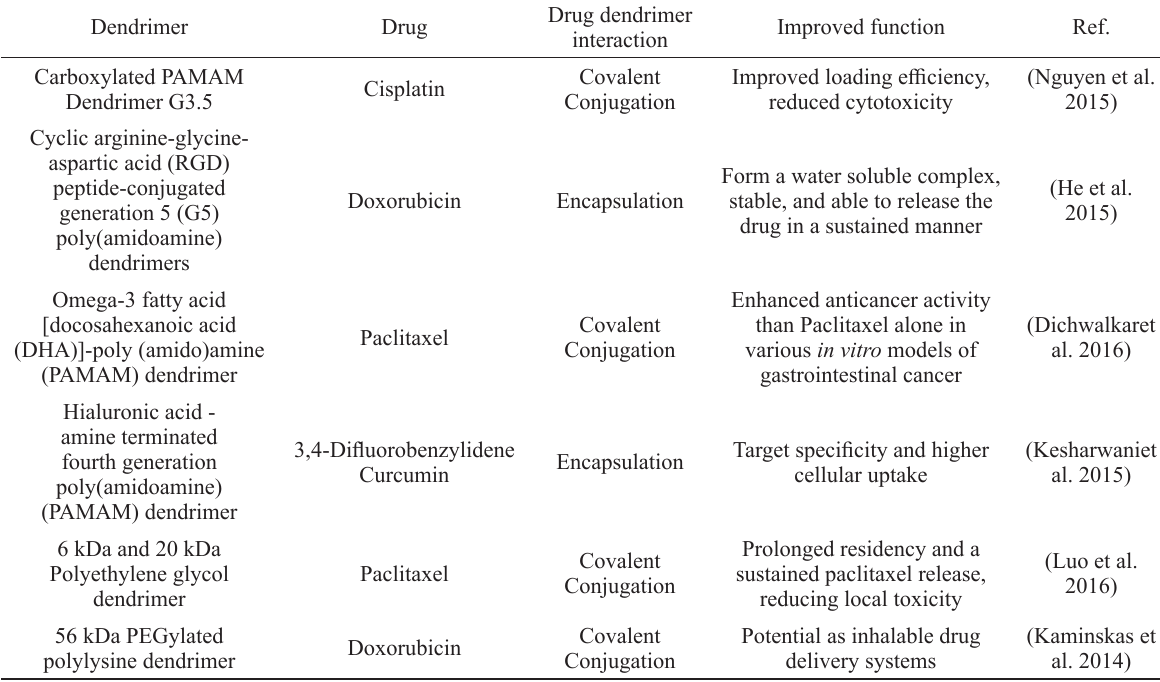
Dendrimer - drug interactions on cancer